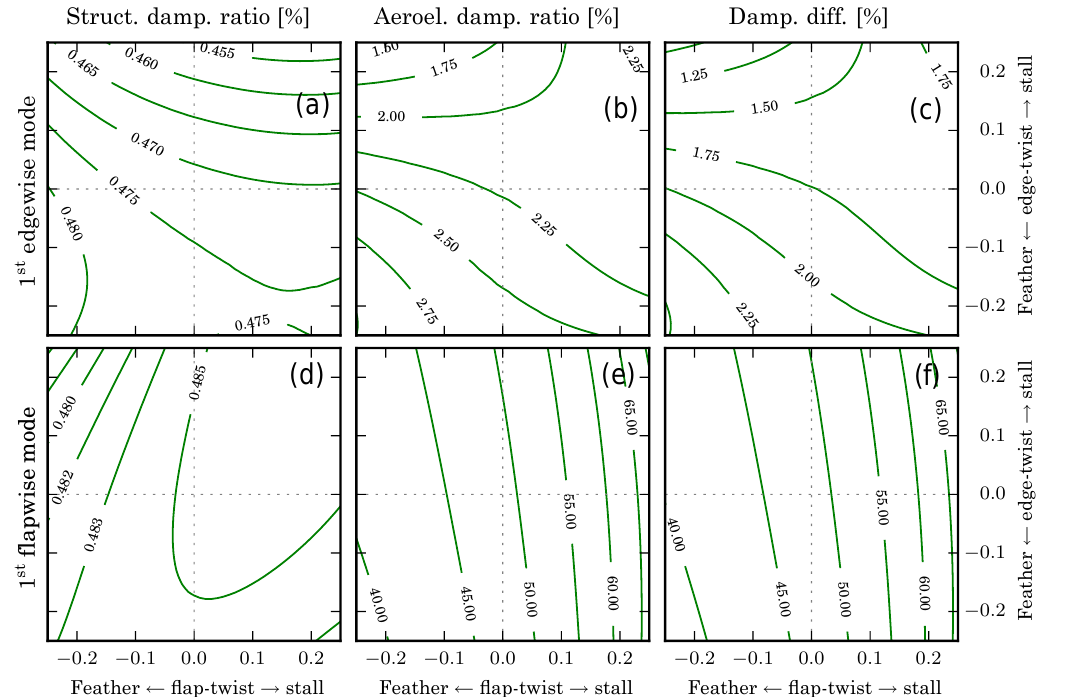
Figure 8. Contour plots of structural (left) and aeroelastic (middle) damping ratios and their difference (right) of the first edgewise (top) and first flapwise (bottom) mode for varying edge–twist (ordinate) and flap–twist (abscissa) coupling coefficients at 8ms − 1 wind